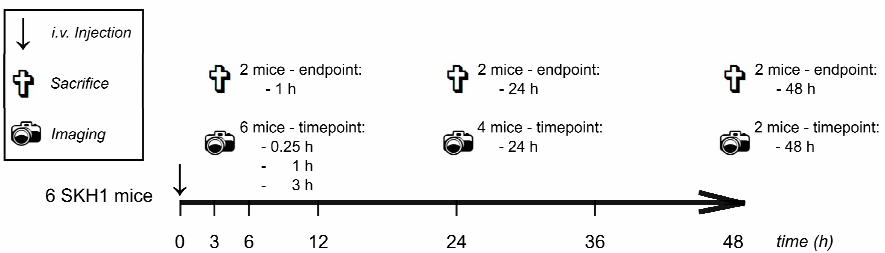
Figure 1. Experimental protocol for in vivo and ex vivo biodistribution study. Both female and male mice were investigated. For each sex, 6 mice were used, respectively.